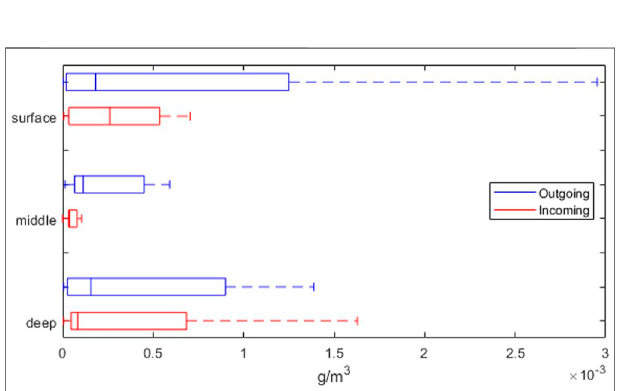
FIGURE 6 | Box plot of the plastic concentration observed at the 3 net levels during the 6 days when surveys were carried out during both ebb and fl ood